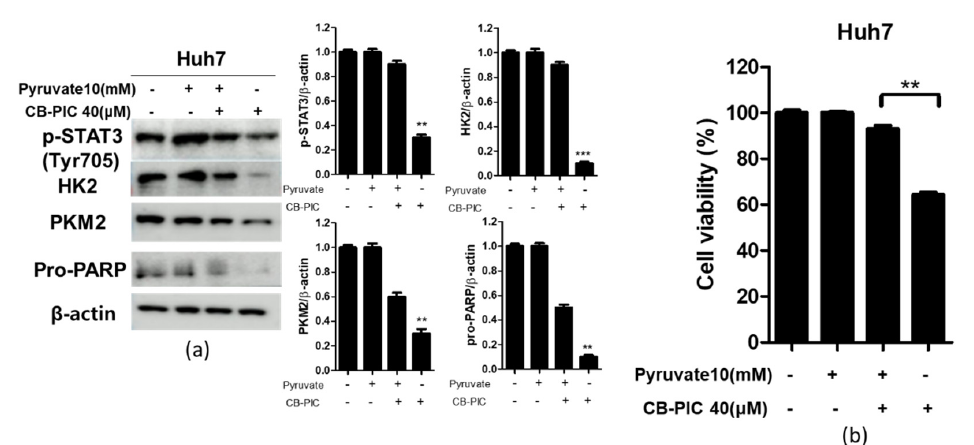
Figure 5. The pivotal role of pyruvate in CB-PIC induced apoptosis and cytotoxicity in Huh7 cells. ( a ) Huh7 cells were treated with CB-PIC (40 µ M) and/or pyruvate (10 mM) for 24 h and cell lysates were prepared and subjected to Western blotting. Data represent means ± SD. ** p < 0.01, *** p < 0.001 vs. untreated control. ( b ) Huh7 cells were treated with CB-PIC (40 μ M) and/or pyruvate (10 mM) for 24 h and then an MTT assay was conducted. Graphs represent relative level of protein expression/ β -actin. Data represent means ± SD. ** p < 0.01 between pyruvate and CB-PIC treated groups.